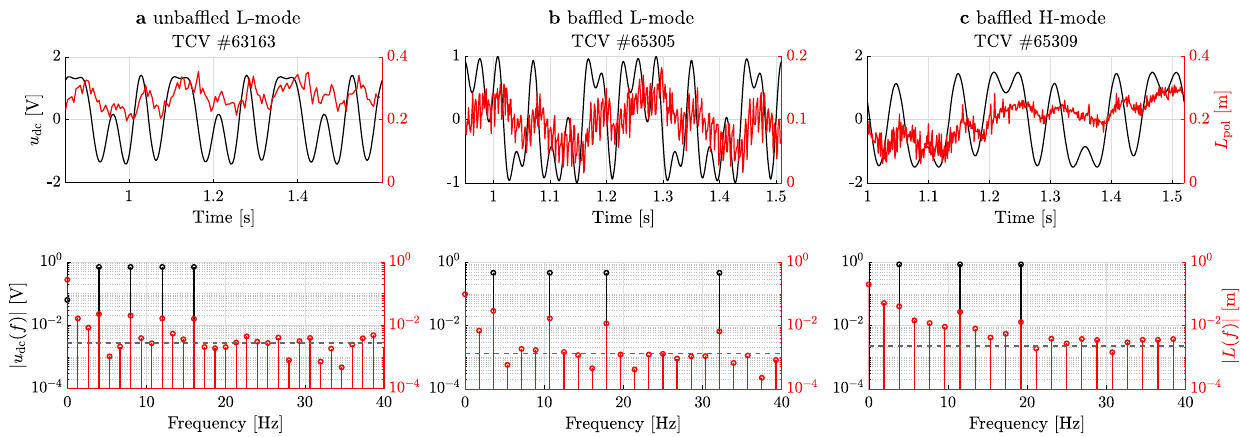
Fig. 5 System identi fi cation experiments. Overview of system identi fi cation results as obtained on the TCV tokamak. Each separate measurement plot contains as a top trace the time evolution of the multi-sine perturbation (black) and response in the emission front L pol (red). In the experiment, the perturbation is summed with a feedfoward waveform to yield the total (always positive) gas valve command. Each bottom plot shows the Discrete-Fourier transform (DFT) of the perturbation (black) and the plasma response (red), a dashed black line shows an estimate of the noise fl oor. This noise fl oor in the unbaf fl ed L-mode experiment ( a ) is high due to the lower (200 Hz) MANTIS frame rate. The baf fl ed L-mode experiment ( b ) has the highest SNR with MANTIS running at 800 Hz. In contrast, the H-mode experiment (in c ) shows a high measurement noise fl oor due to the additional disturbance in the form